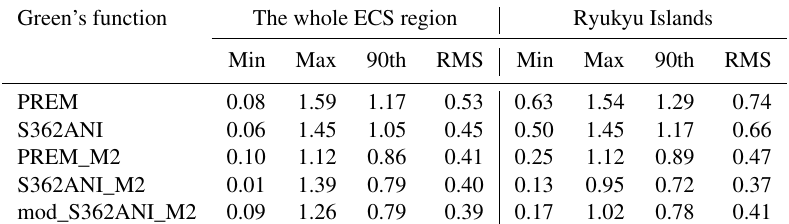
Table 4. Statistics (in millimetres) of the phasor differences between the GPS-observed and predicted M 2 vertical OTL displacements using the NAO99Jb regional ocean tide model (augmented elsewhere globally with FES2014b) and various Green’s functions. The label 90th denotes the percentile.